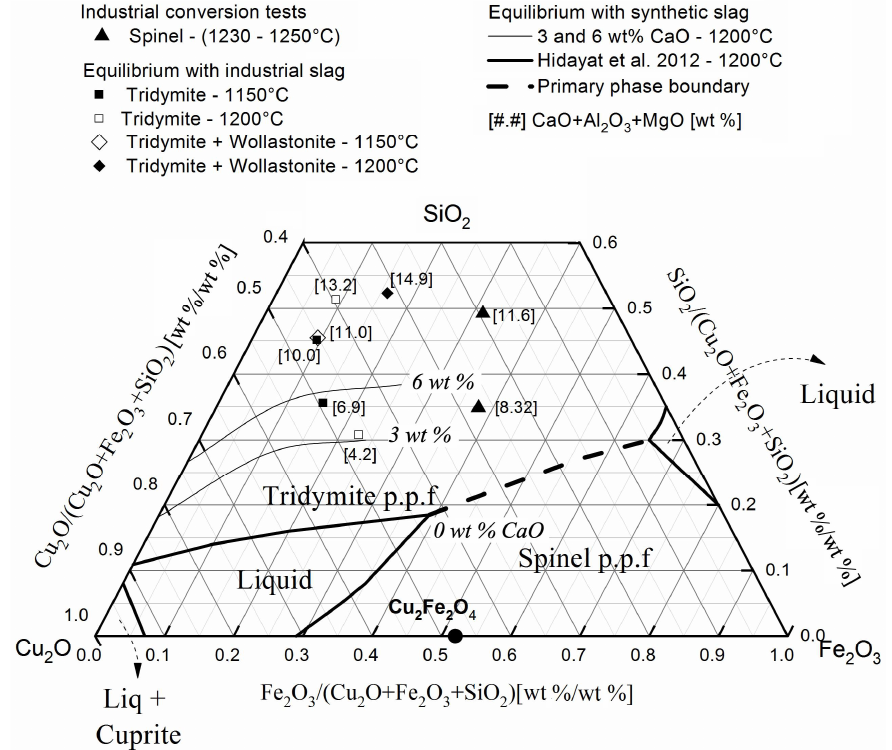
Figure 12. Liquid compositions of equilibrium experiments with industrial slags and industrial tests projected in the phase diagram of the Cu 2 O–Fe 2 O 3 –SiO 2 system compared with equilibrium experiments of synthetic slags with the addition of